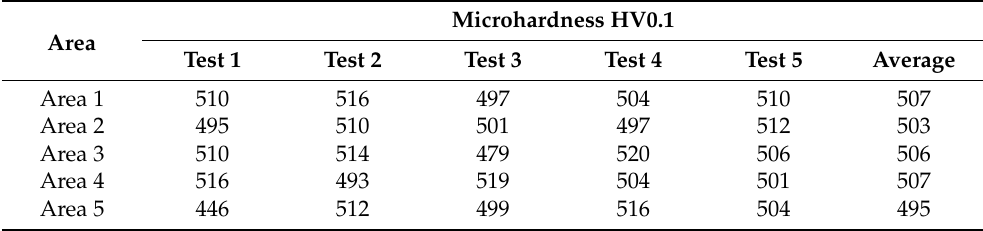
Figure 7. Image of the composite’s structure, wt.%: EP975 + 6CaF 2 with marked imprints of the HV0.1 microhardness measurement: ( a ) Area 1, ( b ) Area 4. Table 8. Results of microhardness HV0.1 measurements in different areas of